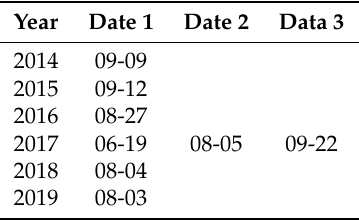
Table 1. Acquisition dates of TLS data in the respective years of the observation period 2014–2019